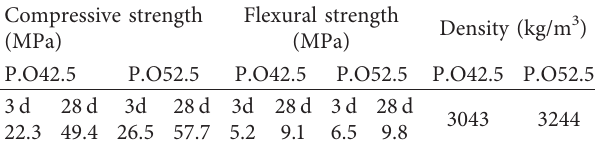
Table 1: Main physical and mechanical properties of